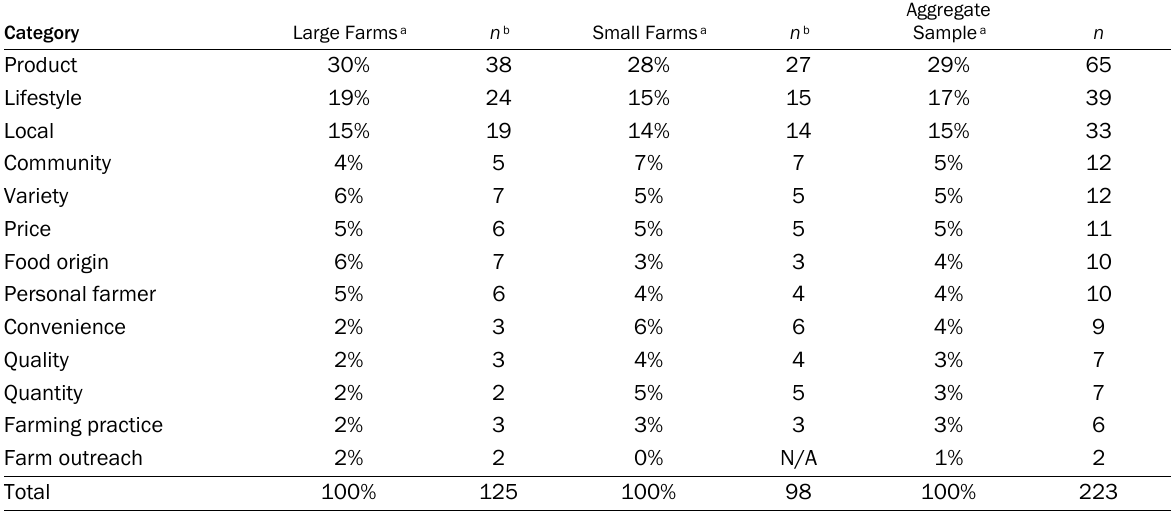
Table 6. Responses to the Question, “What are the benefits of CSA